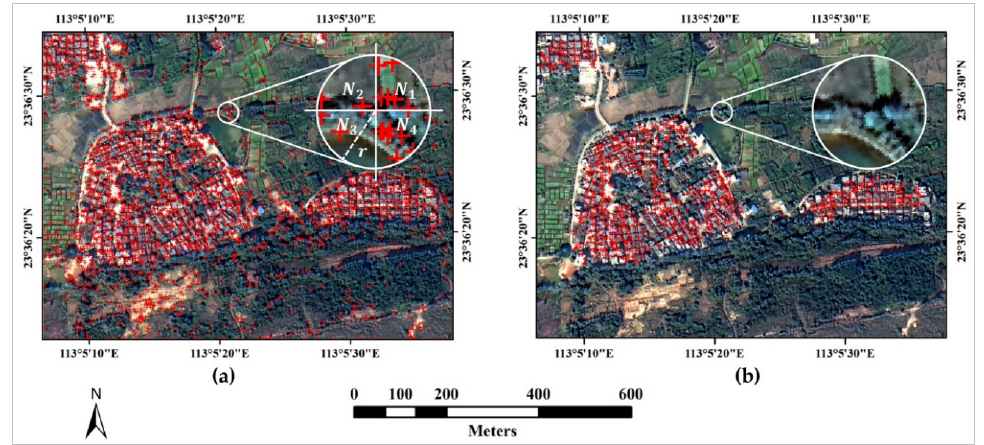
Figure 2. Local feature points detection and optimization. ( a ) Originally detected local feature points; ( b ) Optimized results by the proposed saliency index.